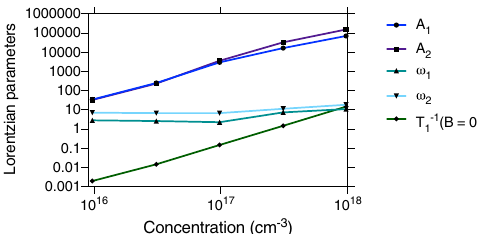
Fig. 9 Concentration dependence in the Lorentzian resonance peak model. Datapoints show the concentration dependence of the fi tting parameters of Eq. (6) fi tted to the simulated spin-1/2 defect concentration-dependent spin relaxation rate curves in Fig. 8b.